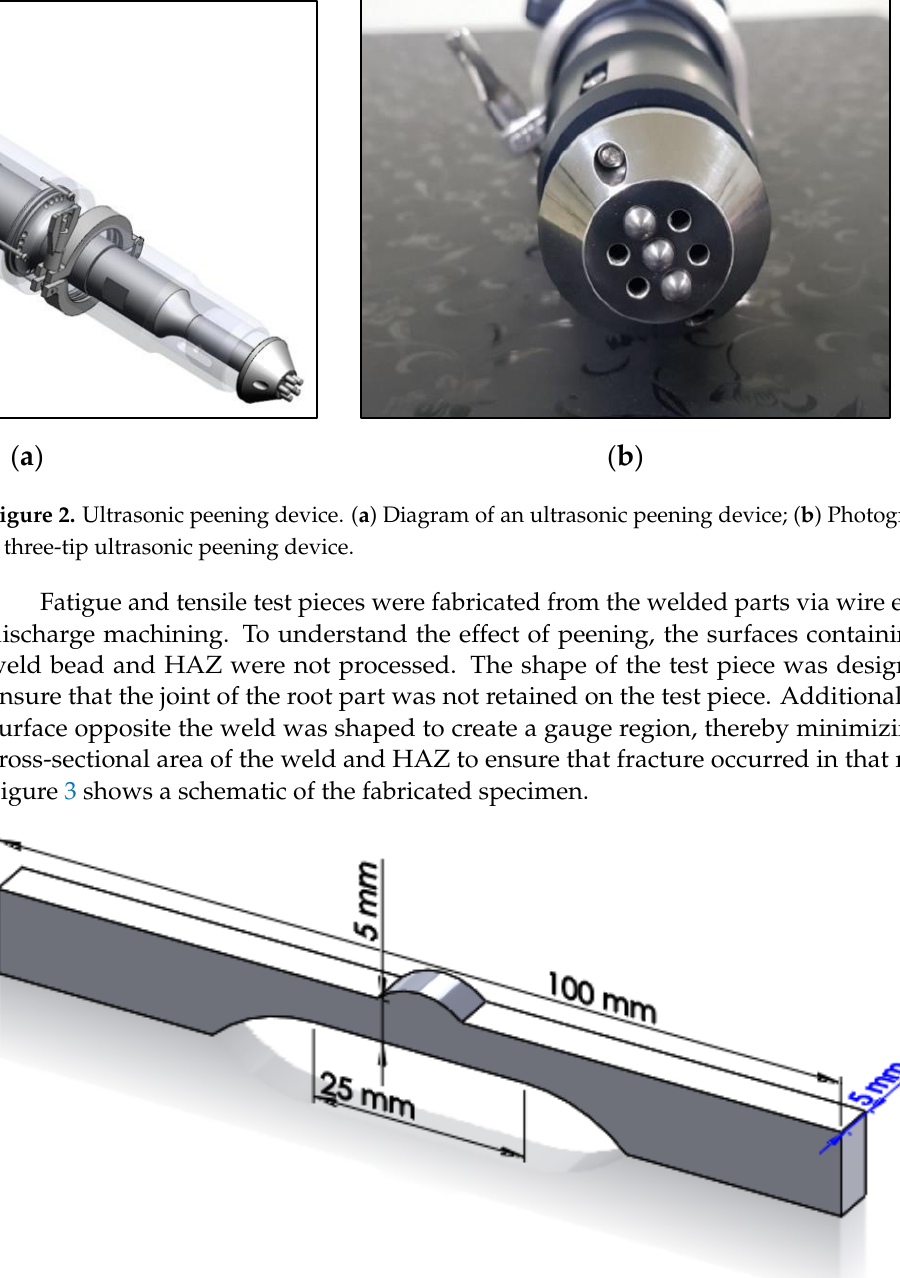
Figure 3. Schematic of the tensile and fatigue test specimen obtained from the welded plates.